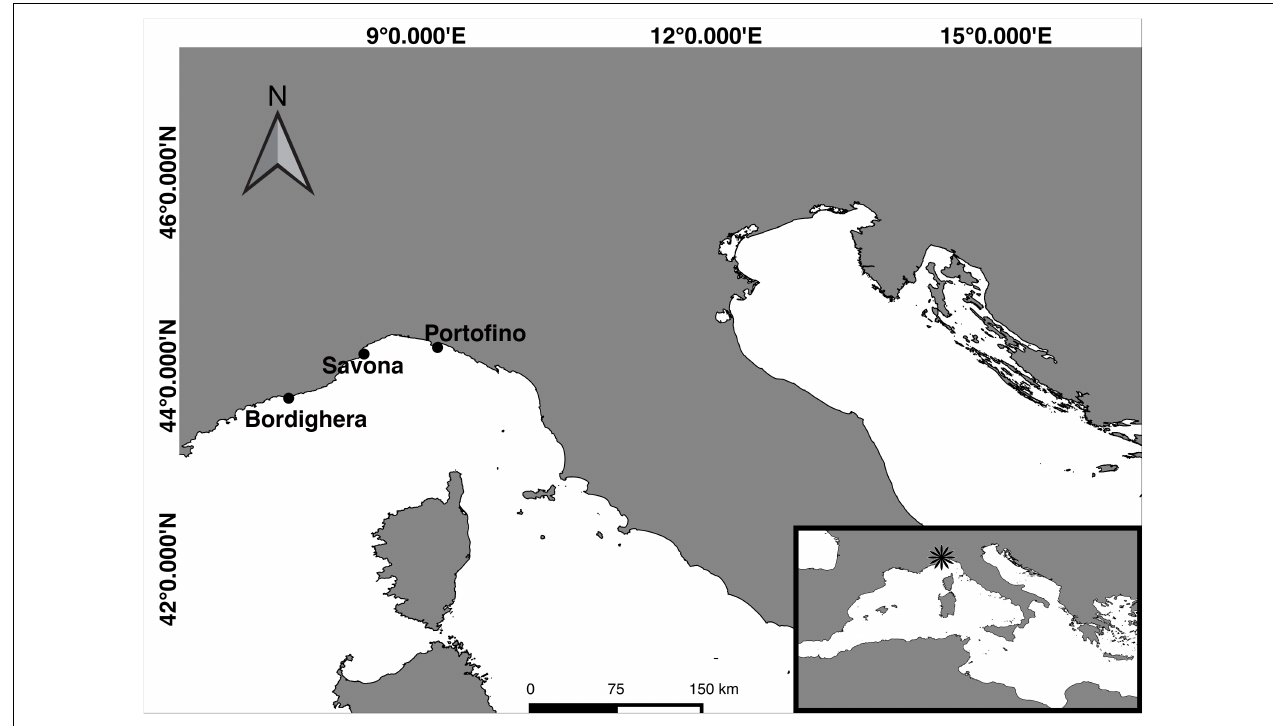
FIGURE 1 | Map of the study sites along the Ligurian coast. Samples were collected from three mesophotic shoals near Bordighera, Savona, and Portofino.